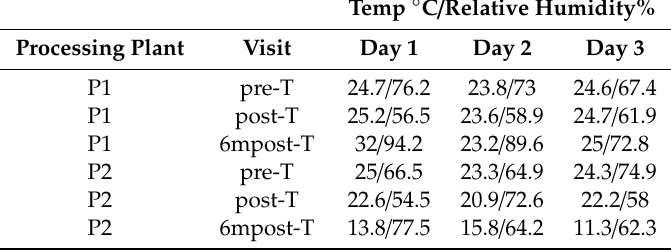
Figure 2. Proportion of crates/drawers containing panting birds n = 60. Table 2. The temperature (°C) and relative humidity (%) in the lairage as measured at the start of the welfare assessment.